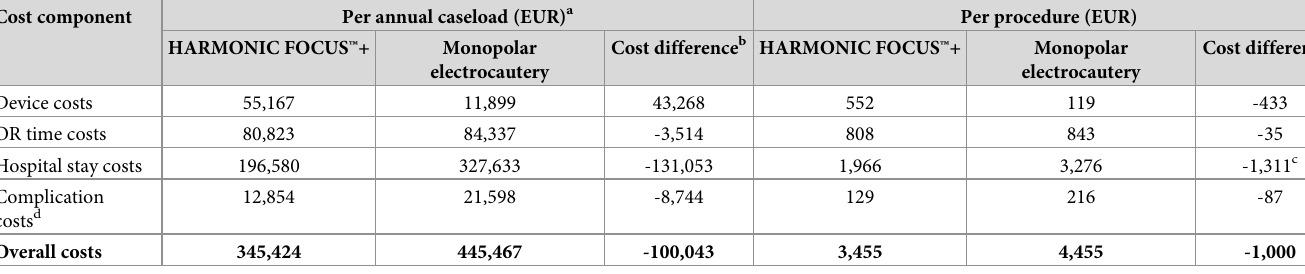
Table 2. Results of the primary